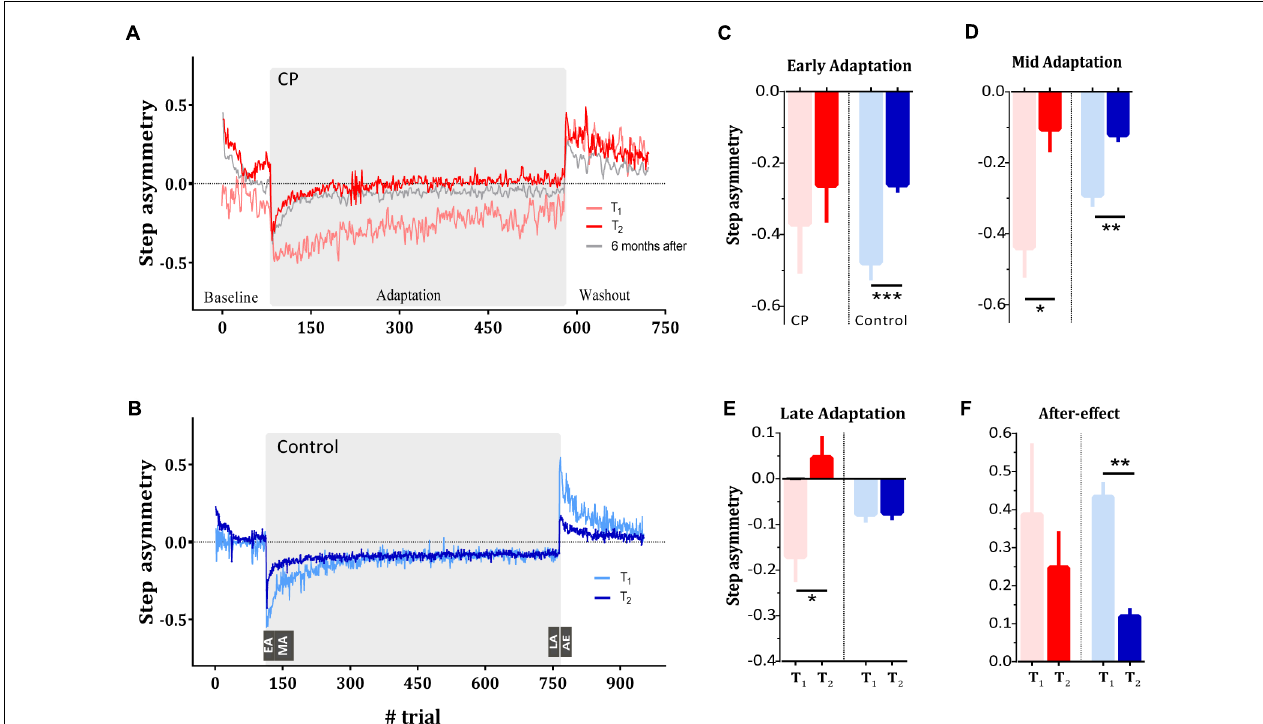
FIGURE 2 | Long-term learning of a split-belt treadmill in typically developed subjects and subjects with CP. (A) Step asymmetry (i.e., motor errors) during split-belt adaptation as quantified by the step asymmetry of the subjects with CP during the first (i.e., T 1 , light red curve) and last (i.e., T 2 , dark red curve) test session. Gray curve represents the adaptation pattern of CP during the 6 months follow up test. (B) Step asymmetry of the control group during the first (i.e., T 1 , light blue curve) and last (i.e., T 2 , dark blue curve) test session. (C) Asymmetry in early adaptation (EA) as quantified by the mean of the step asymmetry of the first 10 strides in the adaptation phase. Red bars represent the mean asymmetry of the CP group whereas blue bars represent the mean asymmetry of the control group. In both groups, light bars and dark bars represent asymmetry at T 1 and T 2 , respectively. (D) Asymmetry in mid adaptation (MA) as quantified by the mean of the step asymmetry of the strides 11–60 in the adaptation phase. (E) Asymmetry in late adaptation (LA), representing asymptotic performance, quantified by the mean of the step asymmetry in the last 10 strides of the adaptation phase. (F) After-effect (AE) in washout phase of the first and last sessions in both groups. Curves and bars represent the means, and error bars represent the standard error of means ( ± SE). Significance levels are as follows: ∗ p < 0.05, ∗∗ p < 0.01, ∗∗∗ p < 0.001.